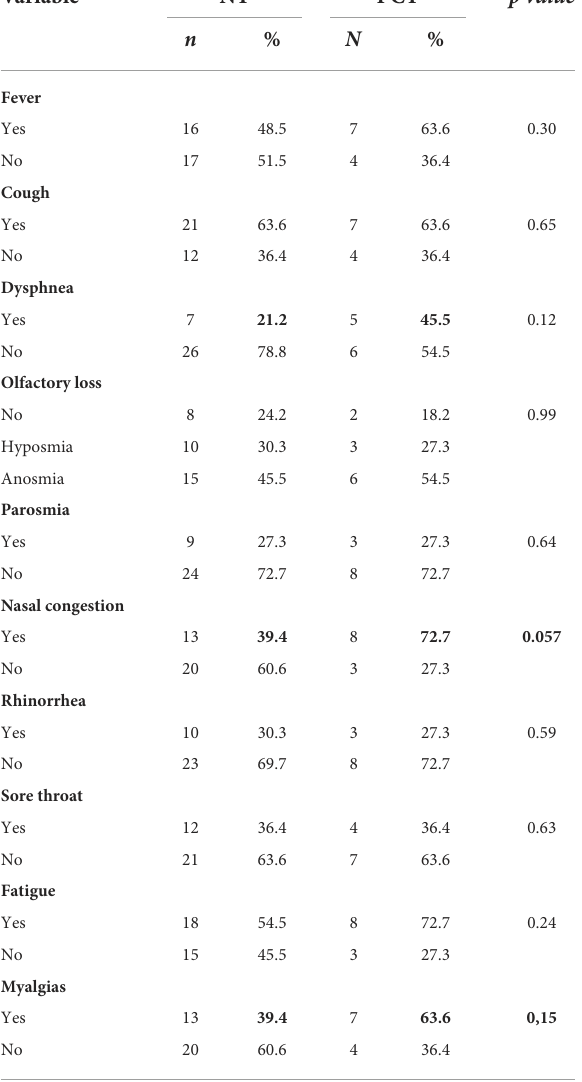
factors may play a role. An online multicenter survey conducted